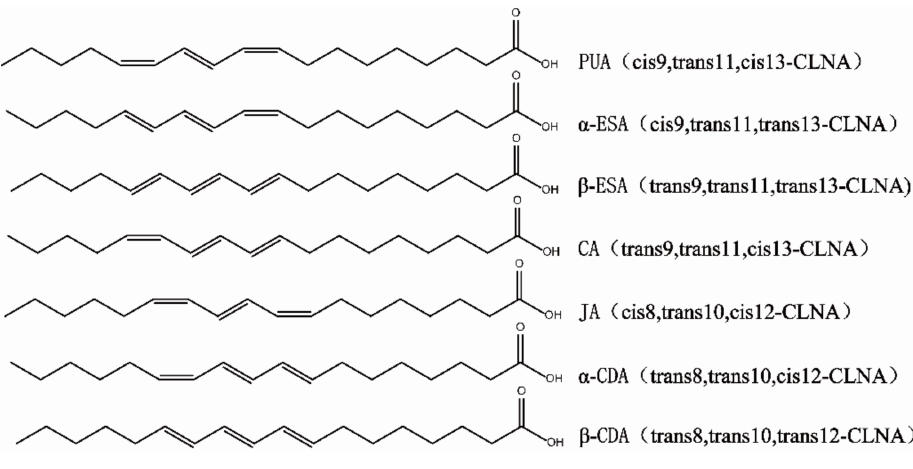
Figure 1. Chemical structure of plant-derived